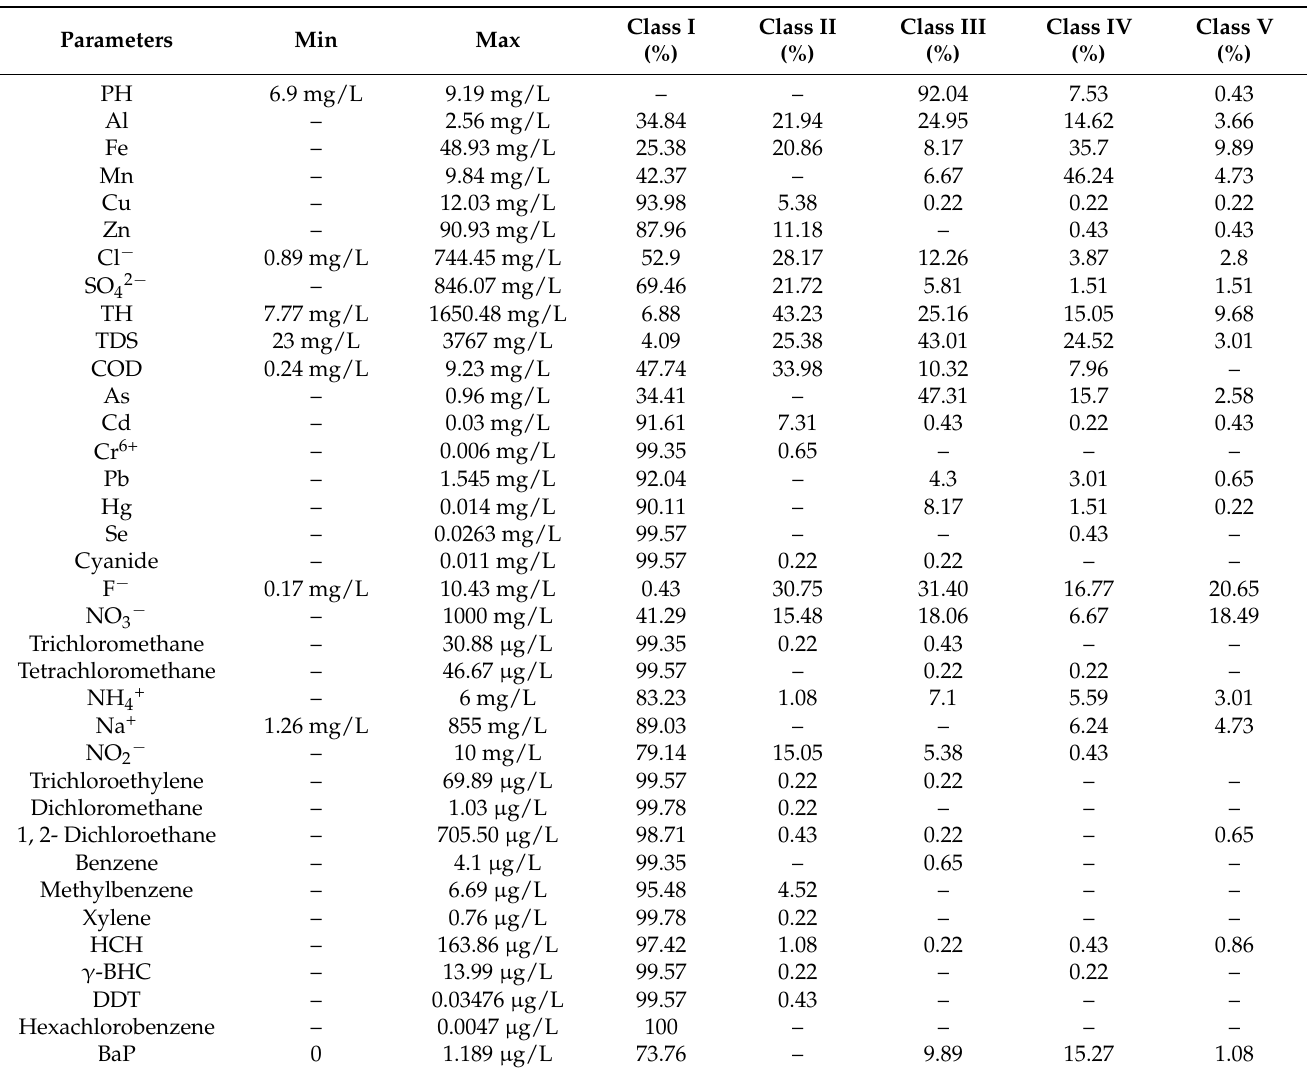
Table 3. Illustrated statistics of physico-chemical elements in groundwater